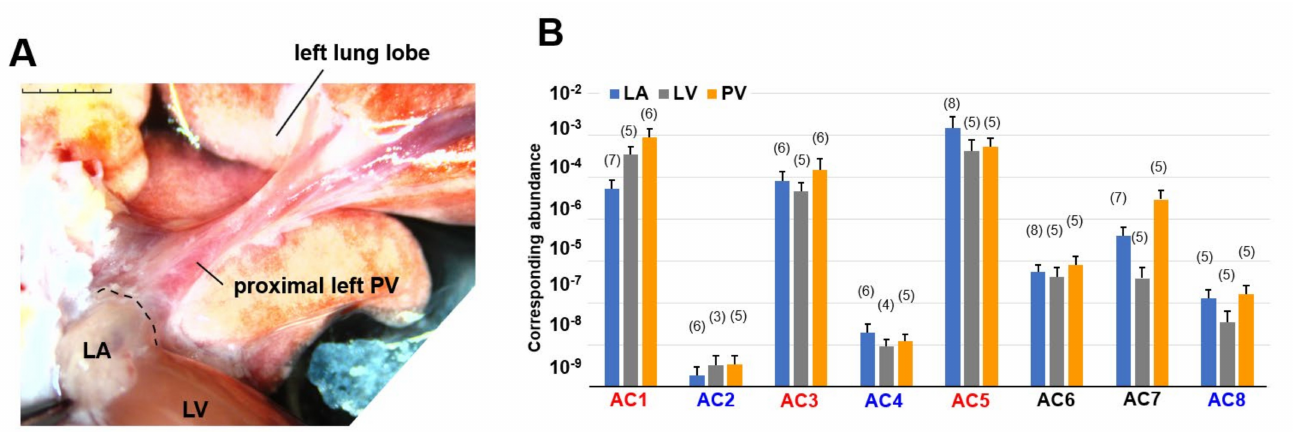
Figure 1. Macroscopic view of the preparation and genetic RT-PCR screening for adenylyl cyclase (AC) superfamily members. ( A ) A stereomicroscopic snapshot of the cardiopulmonary preparation focusing on a left pulmonary vein (PV). To visualize the veins, fresh blood was left inside. The PV extends from the left atrium (LA) and visibly branches into the left superior lung lobe. The post caval lobe of the lung is behind the left PV. The branches from the right PV are out of focus and cannot be fully seen in this view. A part of the left ventricular (LV) mass is observed at the bottom. Scale bar: 5 mm with 1 mm increments. ( B ) Quantitative RT-PCR for AC1–8. By fitting each quantitative cycle to a standard linear curve, the abundance of each reverse-transcribed cDNA is measured quantitatively. The exogenous standard curves are prepared by RT-PCR of diluted RNA extracted from the right atrium. Accordingly, the vertical axis corresponds to the same amount of standard cDNA. The ordinary one-way analysis of variance indicates that expression levels significantly vary from isotype to isotype ( p < 0.0001). Tukey’s multiple comparisons test identified statistically significant differences. AC1, AC3, and AC5 (in red) are all expressed more strongly than AC2, AC4, and AC8 (in blue). To simplify our PCR data, bar graphs with means ± standard deviations instead of dot plots. The number of experiments is provided in